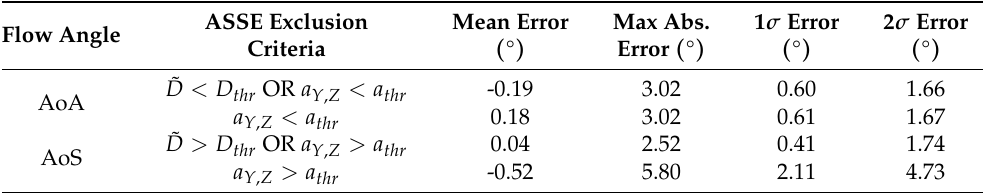
Table 4. ASSE estimation error analysis of the mean, absolute maximum, 1 σ and 2 σ errors. With 1 σ and 2 σ the value is intended such that the probability Pr ( − σ ≤ X ≤ σ ) = 68.3% and Pr ( − 2 σ ≤ X ≤ 2 σ ) = 95.4% also in case the error is not normally